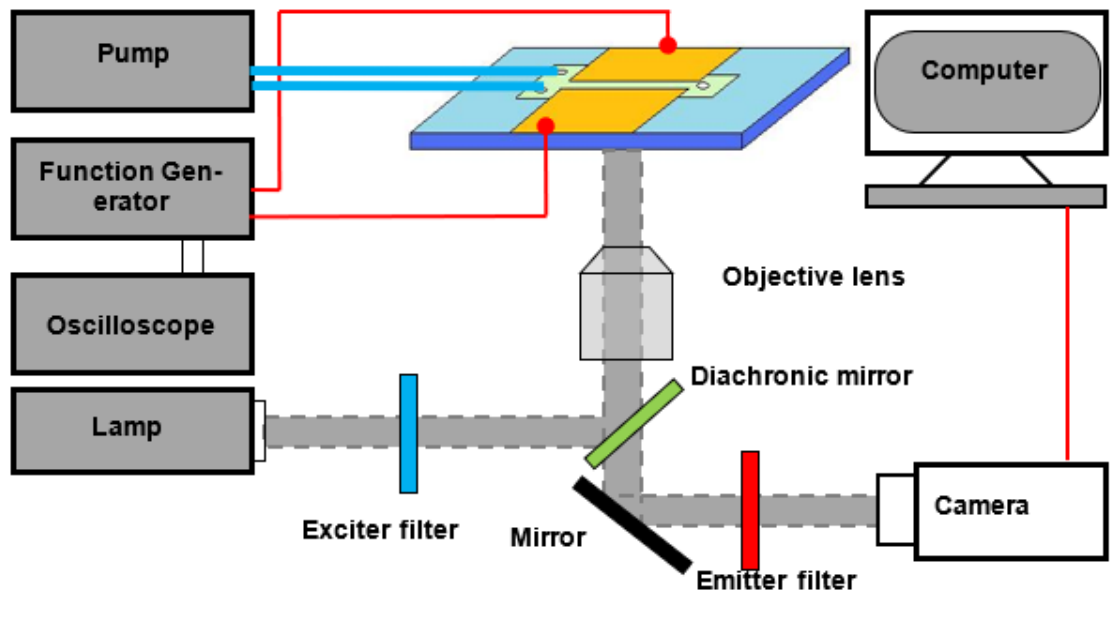
Figure 2. Experimental setup.